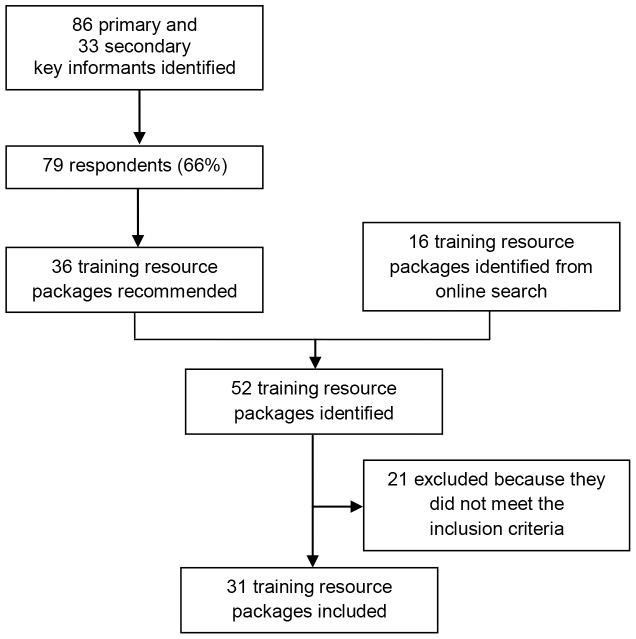
Search strategy.